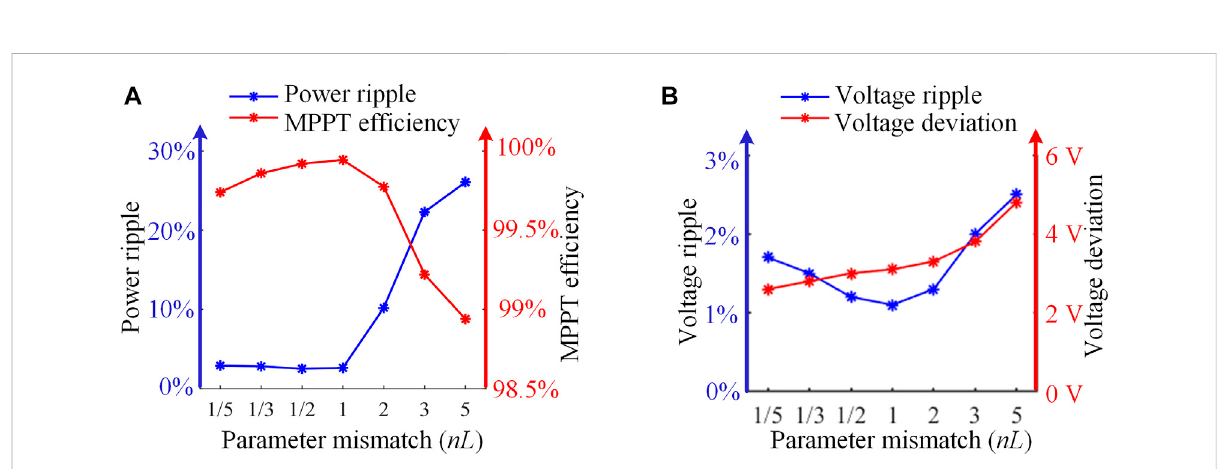
FIGURE 12 In fl uencesofthemismatched L onthemaximumpoweroutputandvoltageregulation. (A) The in fl uenceontheMPPT. (B) Thein fl uenceonthe